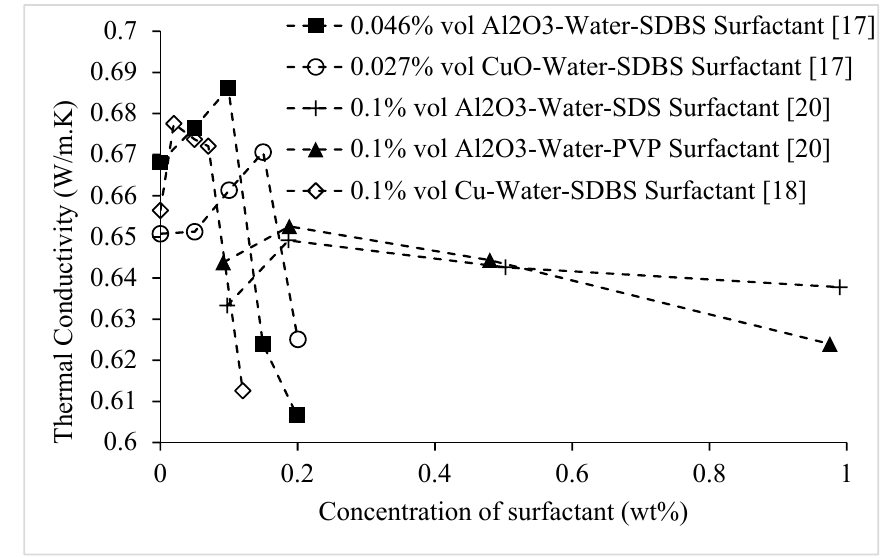
Figure 17. Effect of surfactant on the thermal conductivity of CuO–water and Al 2 O 3 –water nanofluids at room temperature, as a function of surfactant weight concentration. Table 3. Effects of surfactant on nanofluids.